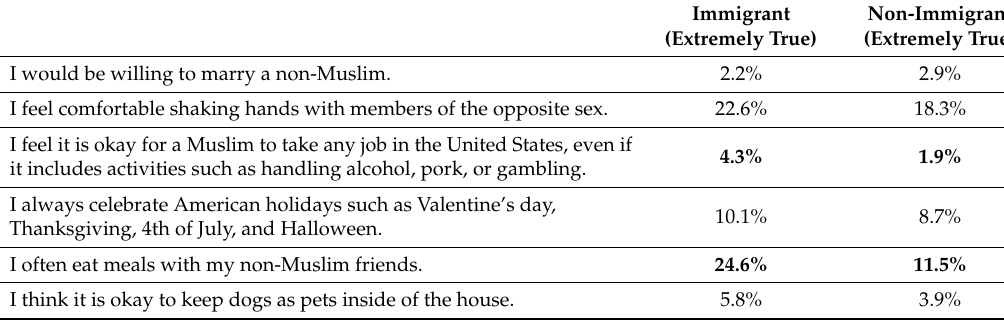
Table 5. Immigrant and Non-Immigrant Item Differences in Conformity to American Norms.